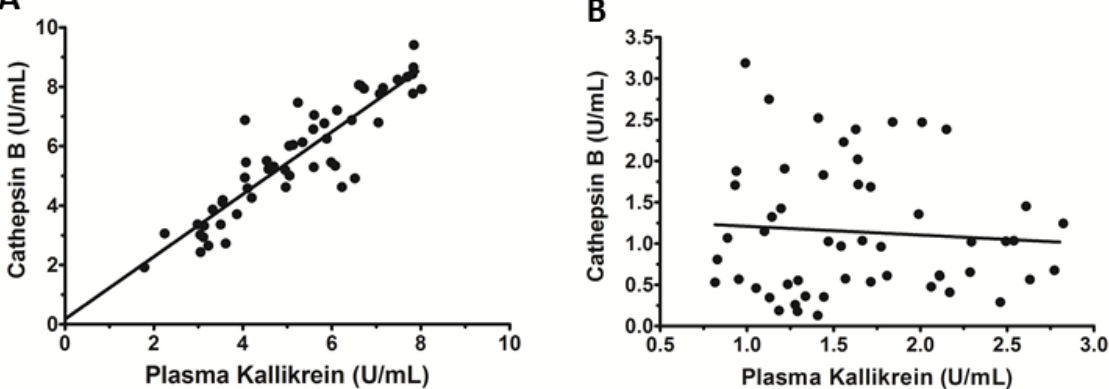
Figure 3. Correlation between cathepsin B (Cat B) and plasma kallikrein (PKa) levels in the serum. Statistical analyses of the data were done using Pearson’s correlation coefficient. ( A ) CHC patients with hepatic fibrosis ≥ A1F2: A strong positive correlation was observed between Cat-B and PKa levels in the serum samples of CHC patients with hepatic fibrosis, Pearson’s r = 0.903; R 2 = 0.816; 95%CI = 0.837–0.943 ( p < 0.0001; N = 53). ( B ) Healt Controls: Pearson’s r = 0.198; R 2 = 0.016; 95%CI = 0.149–0.384 ( p = 0.365; N = 71).